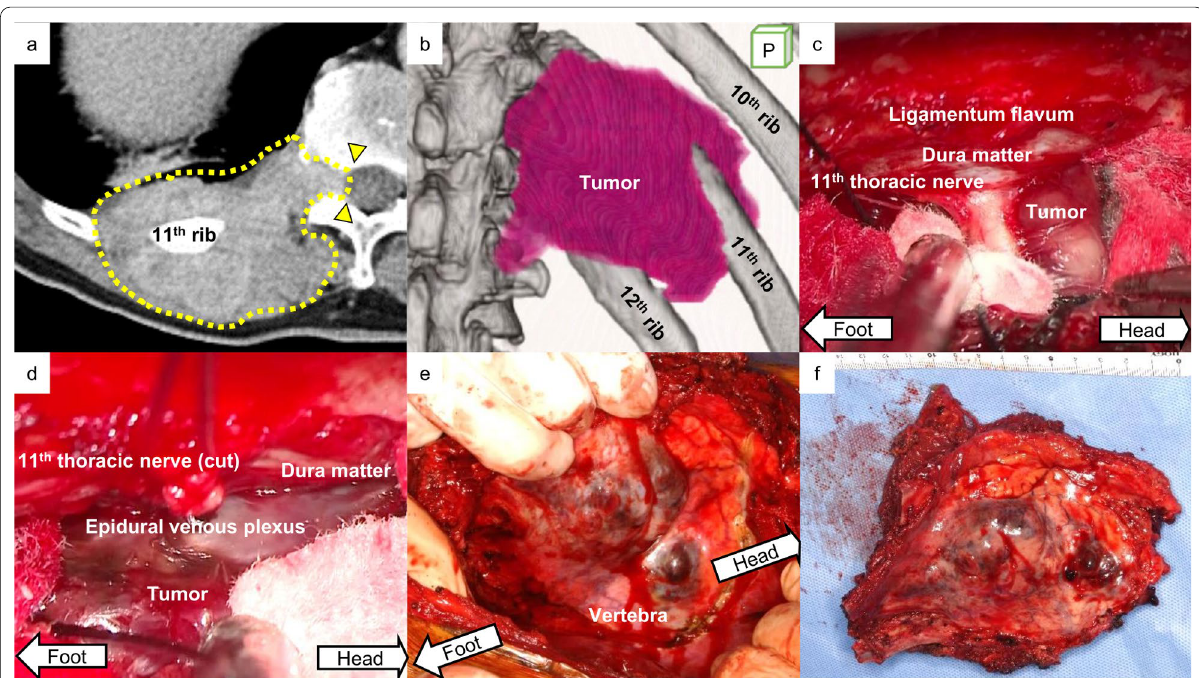
Fig. 1 Images of the tumor and vital surgical procedures. a An axial view of chest CT. A huge dumbbell shaped tumor (yellow dashed line) was developing into the right Th11–Th12 intervertebral foramen and approaching the spinal canal (yellow arrowheads). b A posterior view of the tumor on 3D-CT. The right 11th and 12th ribs were involved in the tumor. c Via the posterior microscopic approach, the end of the tumor was identified as reaching the proximity of the dura mater. d The tumor was successfully separated from the dura matter. e Via thoracotomy, the resection line on the vertebra was carefully determined with surgical margin from the tumor end. f En bloc tumor